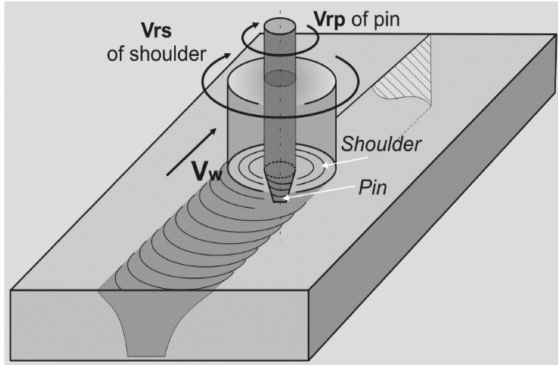
Figure 2. A schema of the FSW process with the dual-speed tool application.